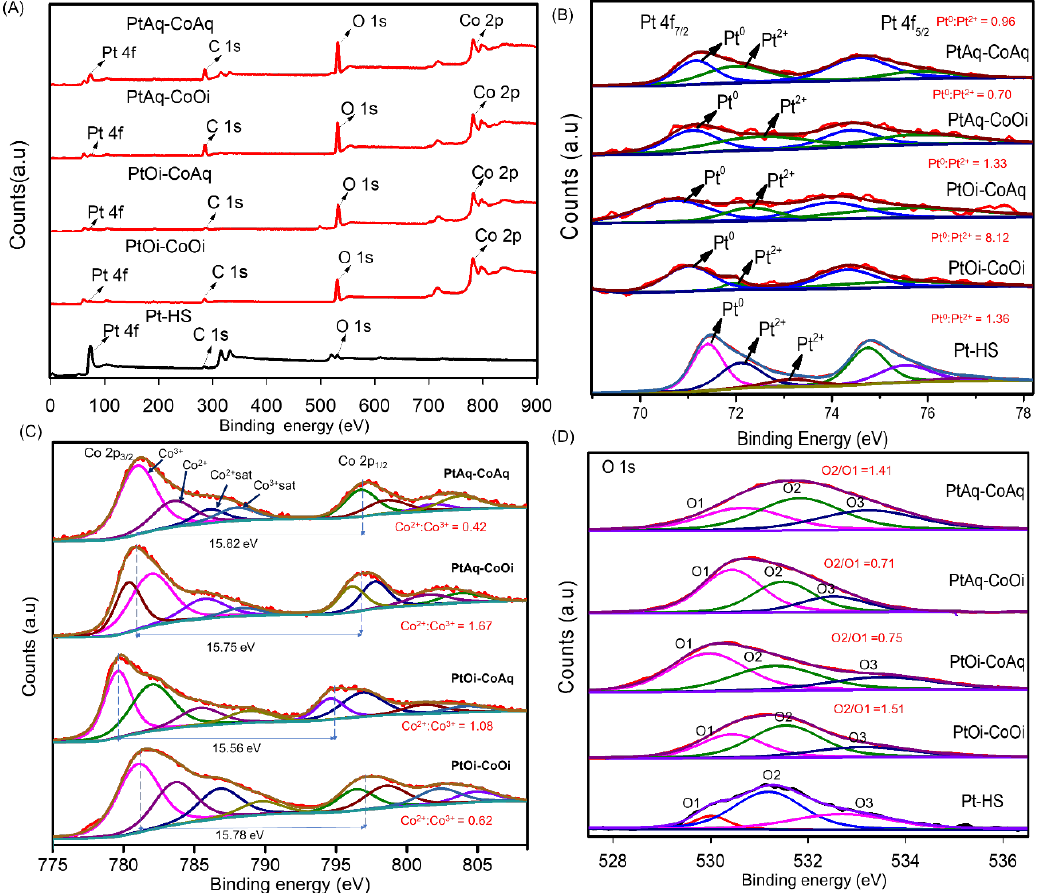
Figure 5. ( A ) XPS survey spectrum of Pt-Co 3 O 4 -HSs and Pt-HS, high-resolution spectra of ( B ) Pt 4f, ( C ) Co 2p, and ( D ) O 1s.